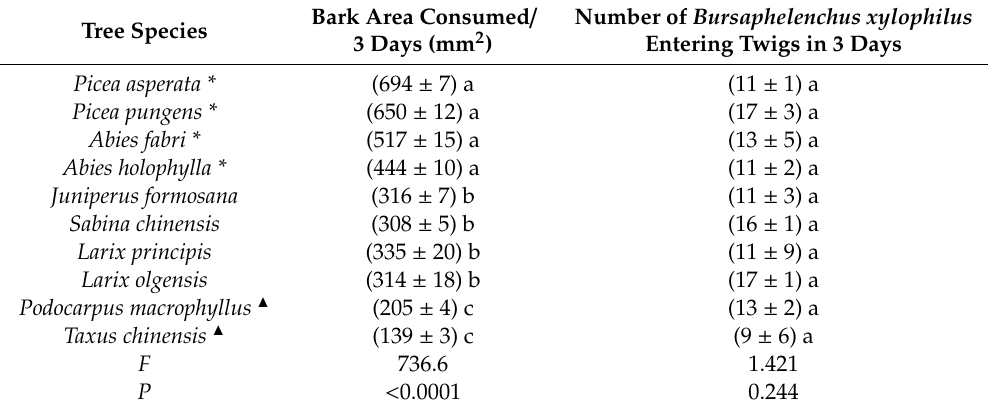
Table 3. Bark area consumed by Monochamus saltuarius and the number of Bursaphelenchus xylophilus entering twigs in 3 days. Data represent the means ± SD of three replicates. Means in the column followed by the same letter did not di ff er significantly at p < 0.05 (method of multiple